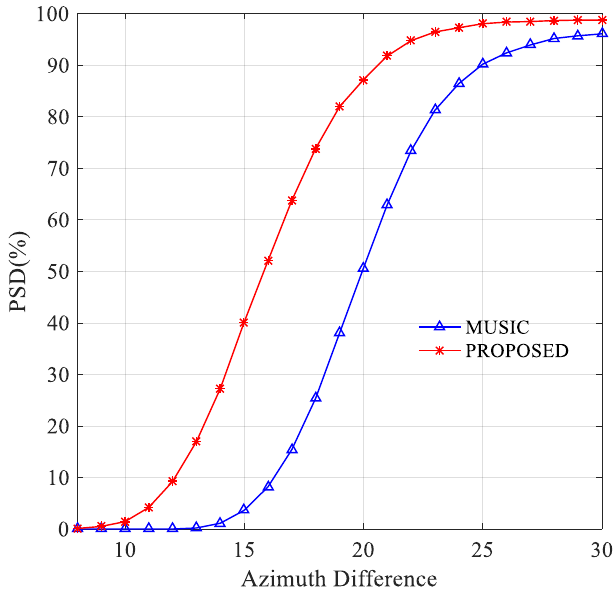
Figure 10. PSD versus azimuth difference.